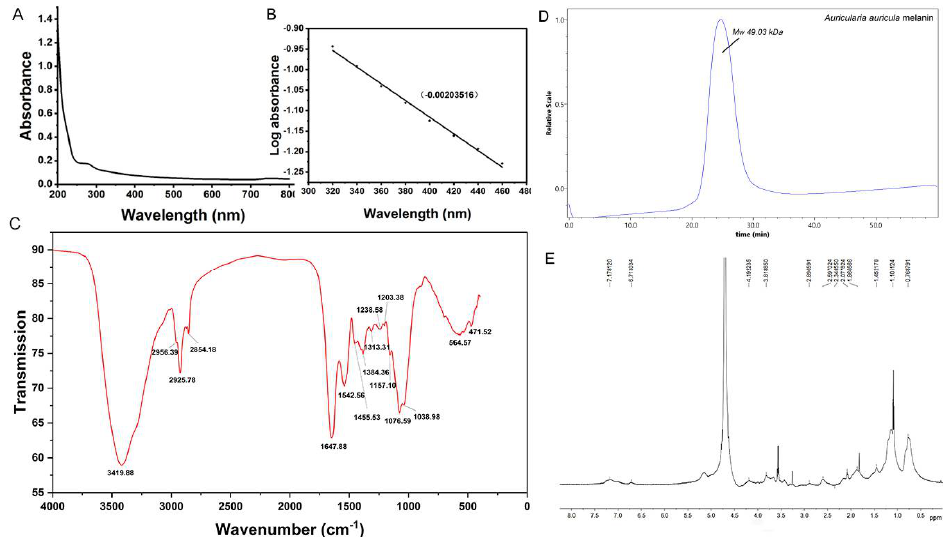
Figure 1. Structural characterization of A. auricula melanin by ( A ) ultraviolet-visible absorption spectrum, ( B ) Logarithm of absorbance to wavelength, ( C ) FT-IR spectrum, ( D ) Gel permeation chromatography (GPC) and ( E ) 1H NMR spectrum.